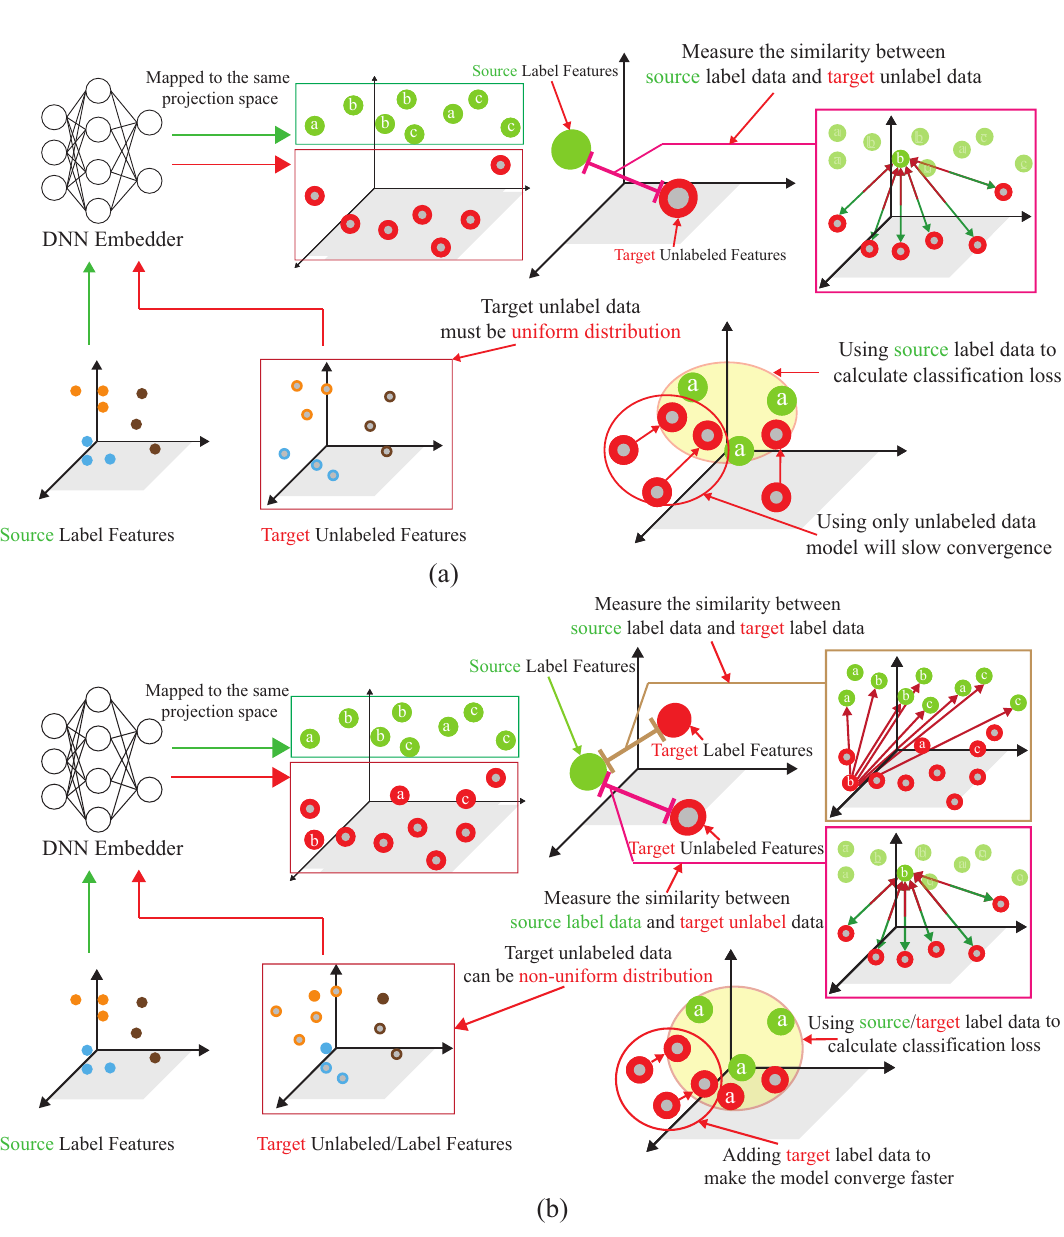
Figure 6. Comparison with ( a ) ADA scheme, and ( b ) our proposed AD-DADA